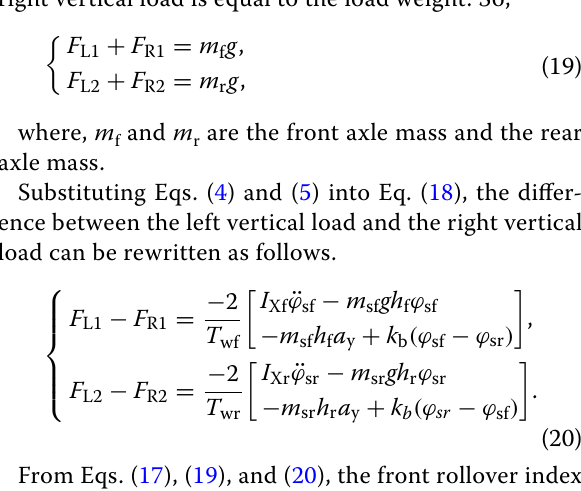
where, K f and K r represent the front wheel cornering stiffnesses and the rear wheel cornering